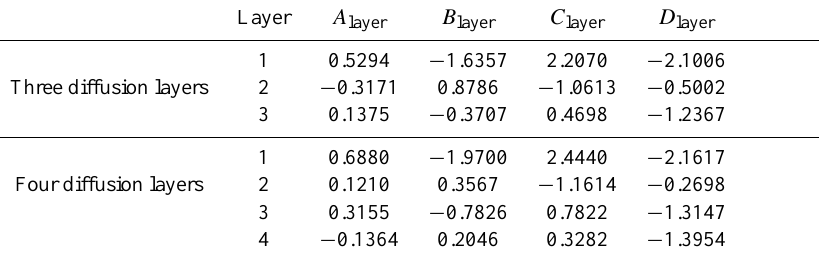
Table 2. Polynomial parameters for Eq.